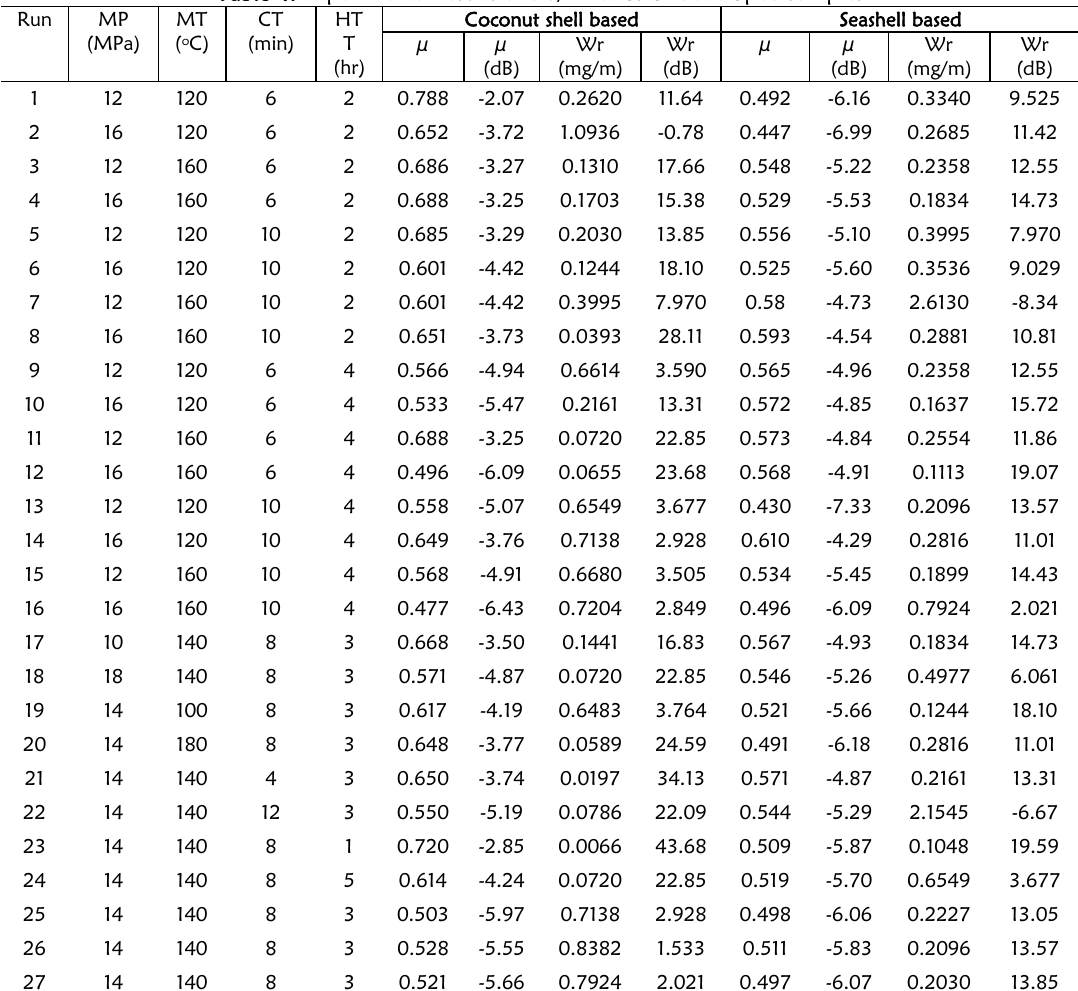
Table 4: Experimental results and S/N ratios of developed